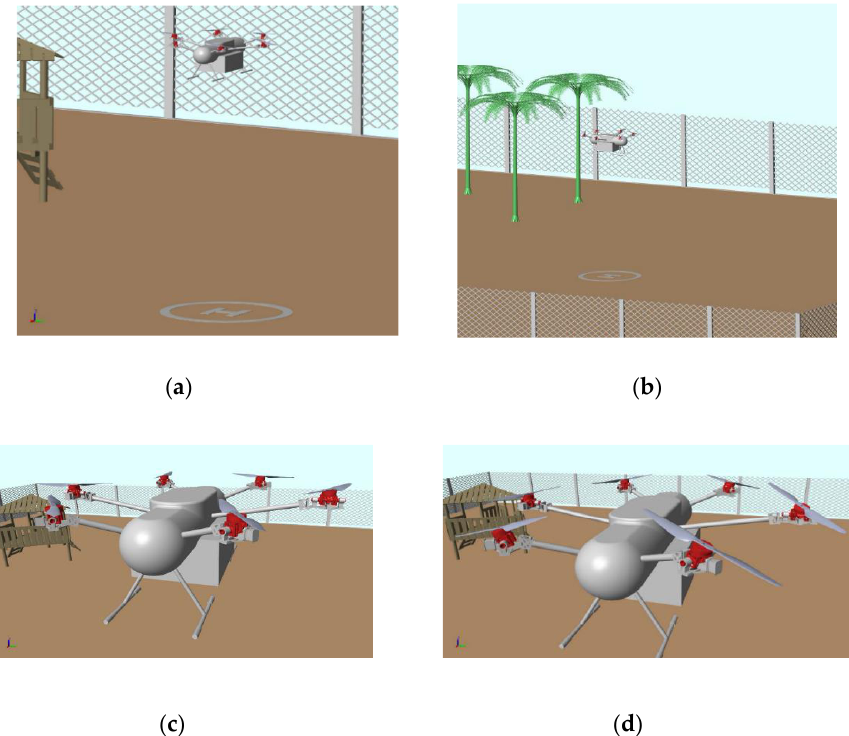
Figure 15. Simulation for hovering flight ( a ) Hovering at a given height in the nominal situation. ( b ) Right-side view of hovering at a given height in the presence of actuator failure. ( c ) Close-up view of hovering flight before actuator failure. ( d ) Close-up view of actuator’s reorientation after actuator failure at recovered hovering.